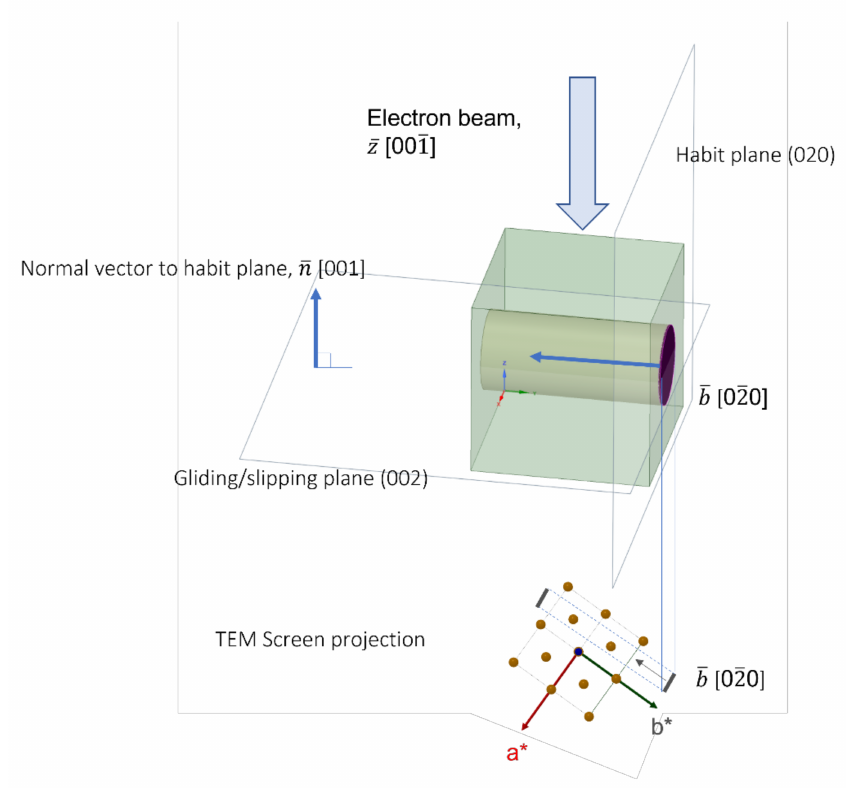
Figure 4. Relationship between the electron beam and the TEM view plane, b, and the loop habit plane. The projection of b depends on the zone axis and the foil